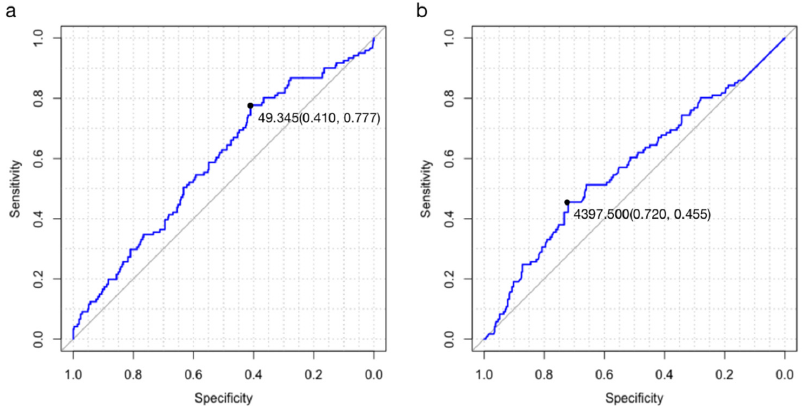
Figure 2. ROC curve for cut-off: ( a ) The ROC of PNI. ( b ) The ROC of BNP.